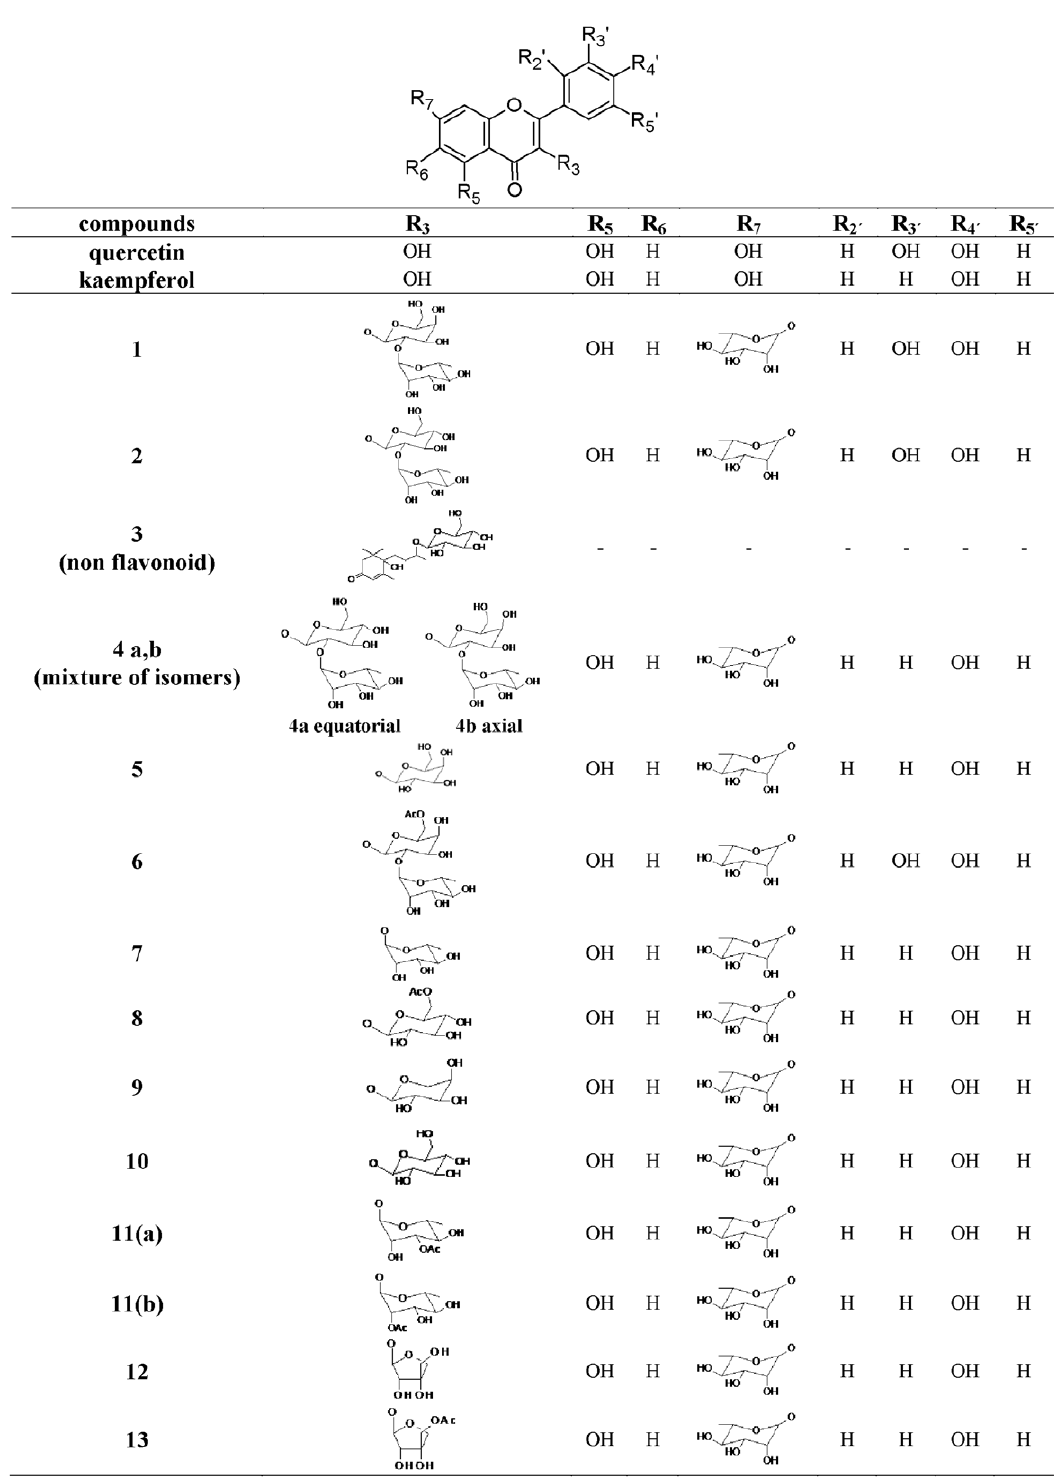
Figure 1. Chemical structures of the polyphenolic compounds isolated from the legume plant extracts. doi:10.1371/journal.pone.0032214.g001 Quercetin 3- O -[ a -L-rhamnopyranosyl(1 R 2)-6- O -acetyl- b -D-galacto- pyranosyl]-7- O - a -L-rhamnopyranoside; Compound 7 : Kaempferol 3- O- a -L-rhamnopyranosyl-7- O- a -L-rhamnopyranoside; Compound 8 : Kaempferol 3- O -(6- O - b -D-acetylglucopyranosyl)-7- O - a -L-rham-